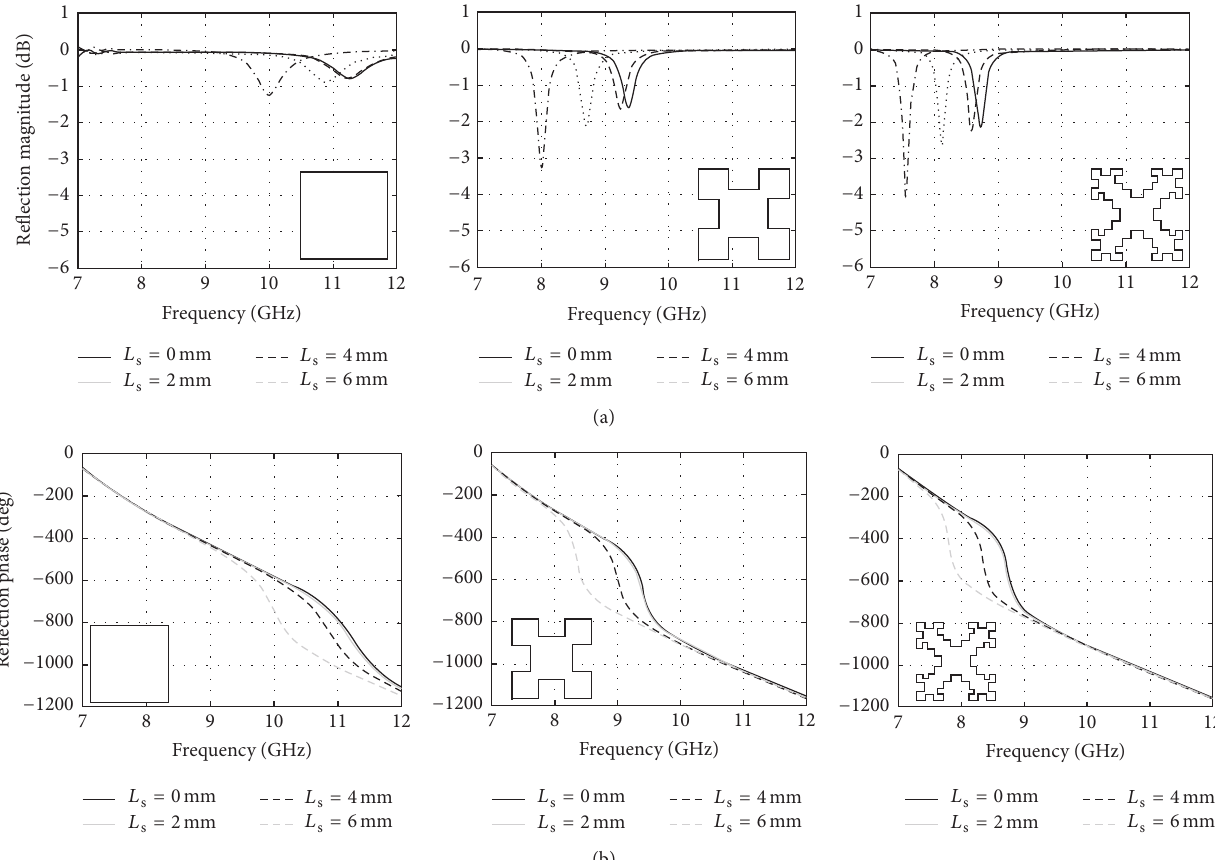
Figure 5: Simulated reflection magnitude (a) and phase (b) for a square, 1st and 2nd Minkowski patches for different slot